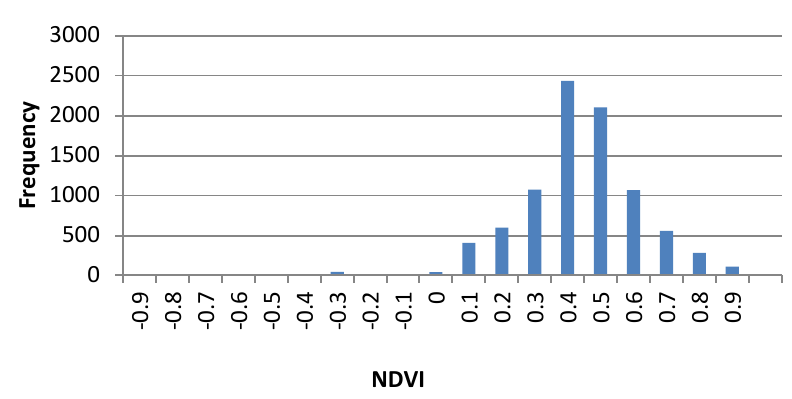
Figure 11. The distribution of NDVI for all clear (non-cloudy, not shaded) observations on EDEN gages across all study image dates was used to partition the samples into low, medium and high vegetation cover classes. While negative NDVI values are sometimes used to detect water, few Everglades locations would ever seem to be inundated based on that criterion. Agreement and omission rates aggregated as a function of these NDVI ranges (Table 4) served as input to tests for analysis of variance (ANOVA), equality of variance, and paired tests for equality of means. ANOVA on agreement and omission rates as a function of NDVI range indicated that both metrics had at least one significantly different pair at the 0.01 level of significance ( i.e. , p = 0.003 for agreement rates and p ≤ 0.0001 for omission rates). Tests of equality of variance were conducted across all pairings and both types of rates (Table